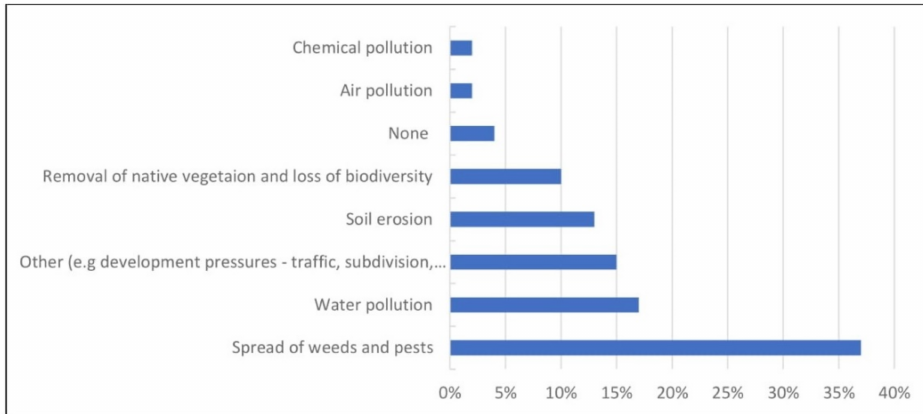
Figure 5. Respondents’ views (by %) of the biggest threats to the Turitea